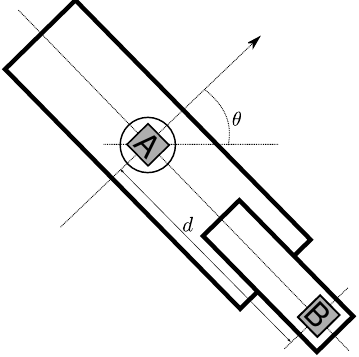
Figure 7. Sensor placement in detail. A: UWB tag, B: PX4